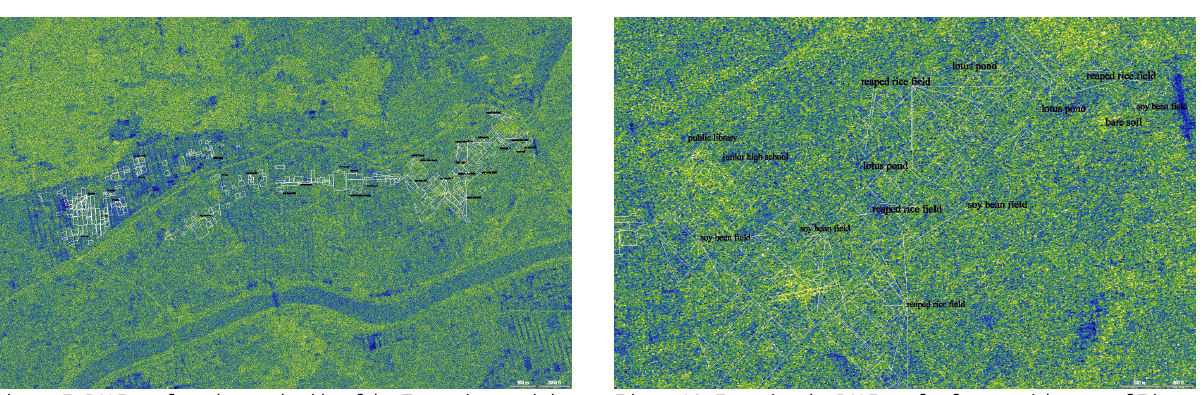
Figure 7. RVI result at the north side of the Tone river and the overlaid-gound-survey-map